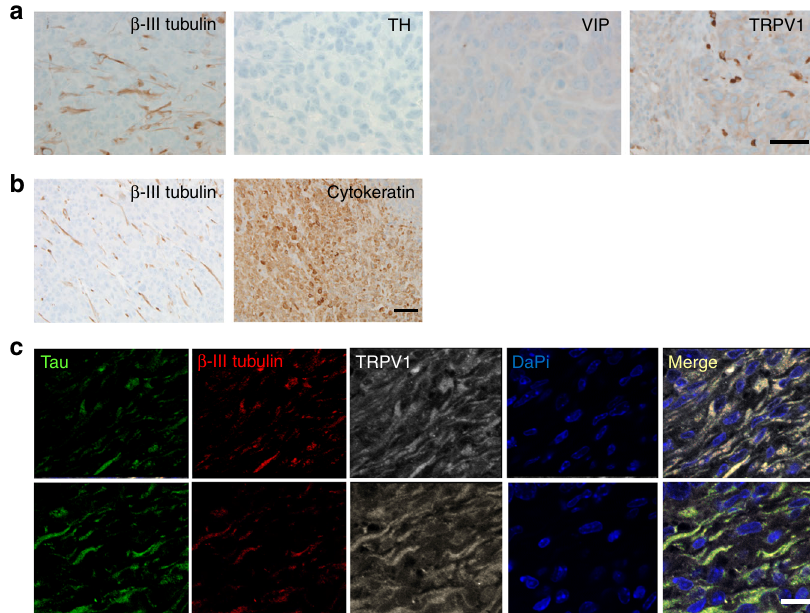
Fig. 4 Sensory innervation of mEERL tumors. a IHC staining of mEERL tumors for β -III tubulin ( n = 30); Tyrosine Hydroxylase (TH), Vasoactive Intestinal Polypeptide (VIP), and Transient Receptor Potential Vanilloid-type one (TRPV1) ( n = 15 additional tumors analyzed for each marker) (scale bar, 20 µ m). Brown, immunostain; blue, counterstain. b IHC stained serial sections of a mEERL parental tumor for β -III tubulin (neuronal marker) and cytokeratin (epithelial marker), scale bar, 50 µ m. c Triple immuno fl uorescent labeling of mEERL tumor for Tau (green), β -III tubulin (red), and TRPV1 (far red, seen as white); merged image presented (merge). Nuclei counterstained with DaPi (blue). Scale bar, 10 µ